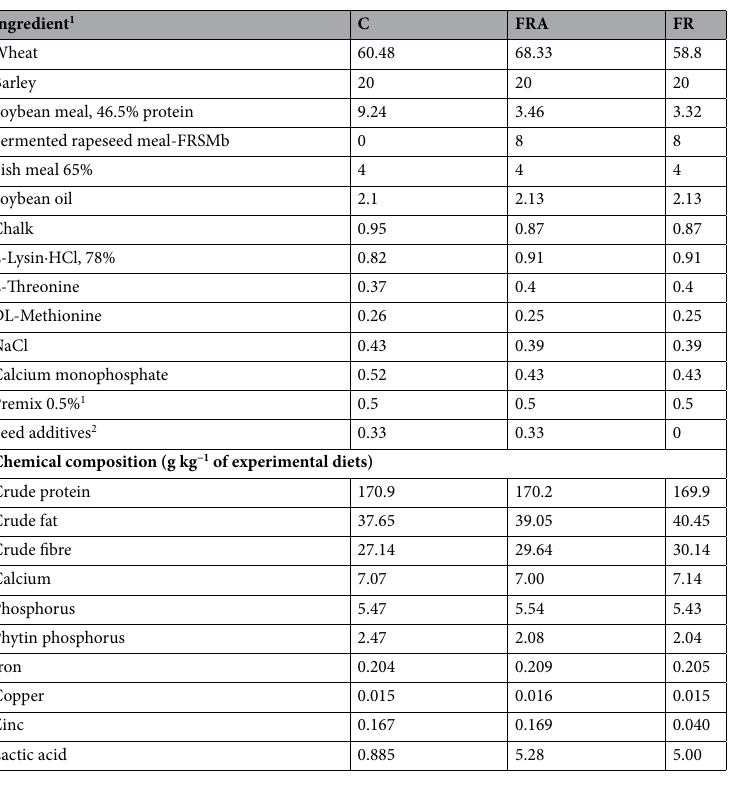
Table 5. Ingredient composition (% of air-dry matter) and chemical composition of piglet. Feeding groups: C control group, FRA weaners receiving a diet with 8% FRSMb and feed additives, FR weaners receiving a diet with 8% FRSMb without feed additives. 1 PremixMineral-vitamin premix, content in 1 kg: Ca 240 g, K 1 g, Fe 20 g, Mn 11 g, Cu 2.5 g, Se 60.0 mg, I 120 mg, Co 150 mg, vit. A 1,600,000 IU, vit. D3 200,000 IU, vit. E 10.0 g, vit. K 600 mg, vit. B1 500 mg, vit. B2 1400 mg, vit. B6 800 mg, vit. B12 10.0 mg, nicotinic acid 4.0 g,